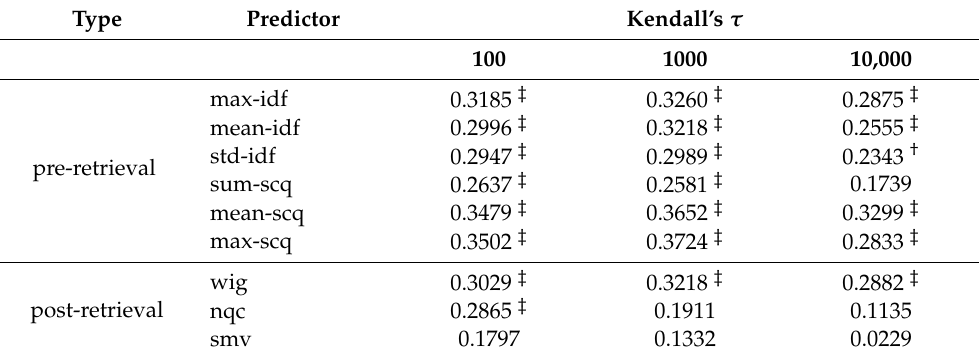
Table 2. Kendall’s τ correlation observed between recall and prediction scores for both pre- and post- retrieval traditional predictors, if we compare the default formulations of different topics. Results are in line with correlation values previously observed in other scenarios. The symbol † indicates that the correlation is statistically greater than 0 at level α = 0.05, while the ‡ indicates a significance level of 0.01, the absence of any symbol indicates that results cannot be deemed statistically greater than 0. We compute the Kendall’s τ correlation at different cutoff levels of the ranked lists (100, 1000, and 10,000). Type Predictor Kendall’s τ 100 1000 10,000 max-idf 0.3185 ‡ 0.3260 ‡ 0.2875 ‡ pre-retrieval